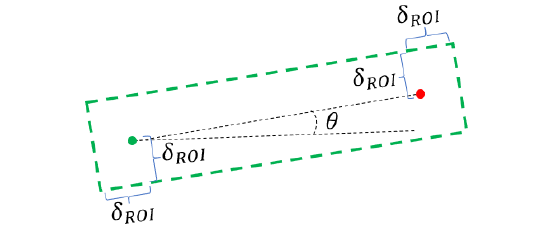
Figure 4. Example of reducing number of vertices to simplify the associated visibility graph. The left illustration shows three original polygons. The right illustration shows the polygons after applying the vertex downsampling algorithm. n maxVert and p dwnSmple are 15 and 60%, respectively. The time complexity of visibility graph generation is O ( n 2 log ( n )) , where n is the total number of vertices in all polygons. The number of vertices in the lower polygon illustrated here is reduced from 15 to 9.